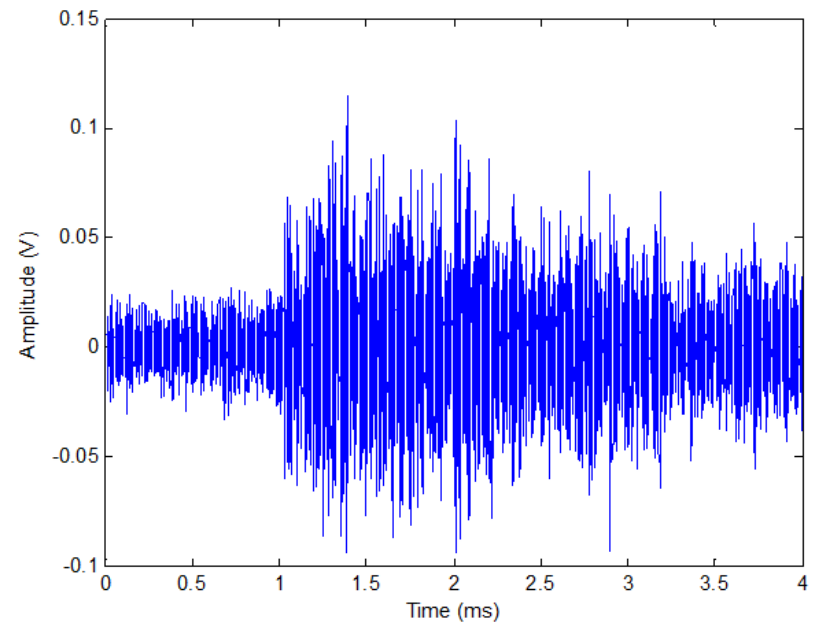
Figure 5. Raw acoustic emission (AE) signal at deflection of 3.22 mm.